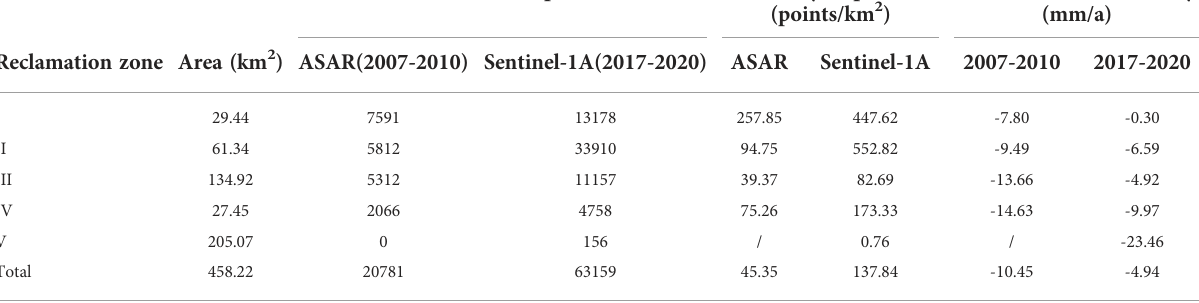
Number of PS points Density of points